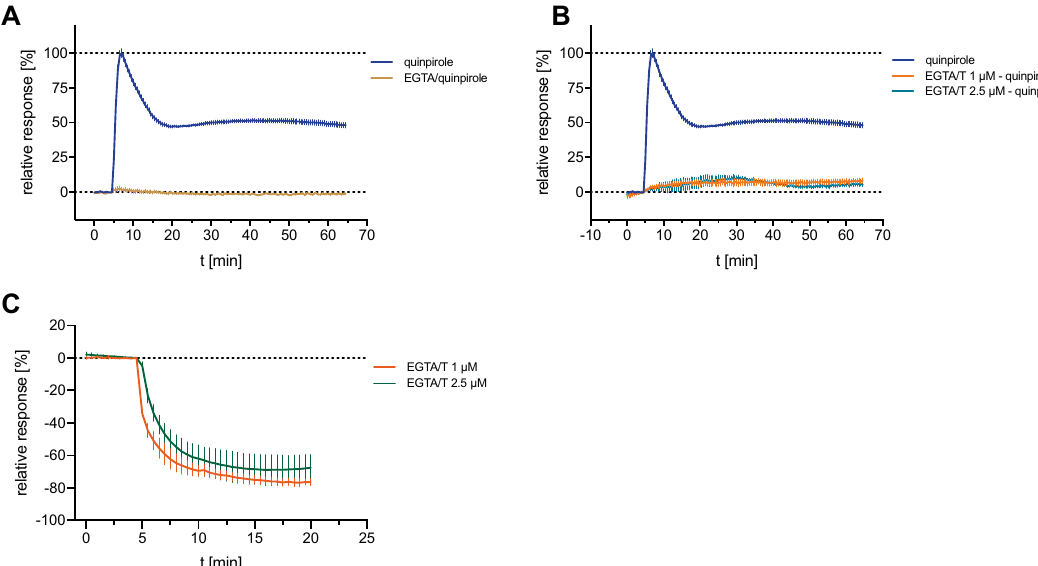
Figure 7. Effects of calcium depletion on the quinpirole-induced DMR traces of hD 2long R expressing CHO-K1 cells. ( A ) Response induced by quinpirole (1 μM) in the absence or in the presence of EGTA (2 mM) in the assay buffer. ( B ) Cells were pre-incubated with thapsigargin (1 μM or 2 μM) for 20 min before the addition of quinpirole (1 μM). EGTA (2 mM) was present in the assay buffer. ( C ) Thapsigargin-induced effect on CHO-K1 hD 2long R cells. The assay buffer was supplemented with EGTA (2 mM). In all experiments, after replacement of the medium by the EGTA-containing buffer, cells were allowed to condition in the pre-heated plate reader (28 °C) for 2 h. Data were normalised to the maximum change in wavelength shift induced by quinpirole (1 μM) observed in untreated CHO-K1 hD 2long R cells (100%) and a buffer control (0%). Data shown are means ± SEM of representative recordings performed in triplicate of three independent of [Ca 2+ ] i after stimulating the hD 2long R expressed in CHO-K1 cells with quinpirole was explored by performing a Fura-2 calcium assay. Only high concentrations of quinpirole (1 μM and 10 μM) induced a low increase in intracellular Ca 2+ concentration in CHO-K1 hD 2long R cells over the buffer control (1.7-fold, cf. Supplementary Fig. S12, SI). For comparison, activation of the muscarinic M 3 receptor, a G q/11 -coupled receptor, results in an about tenfold increase in intracellular Ca 2+ -concentration in a Fura-2 assay using CHO-hM 3 R cells 67 . Conse- quently, the abrogation of the DMR response by treatment with EGTA and/or thapsigargin must have different underlying mechanisms. A potential effect of Ca 2+ depletion on the binding of quinpirole to the receptor was considered a possible reason. Therefore, radioligand competition binding experiments were performed in the presence of EGTA (2 mM). However, the results showed that chelation of Ca 2+ ions by EGTA had no marked effect on the binding of quinpirole to the hD 2long R. (cf. Supplementary Fig. S13, SI). In conclusion, extracellular or extra- and intracellular depletion of calcium resulted in conditions under which either the hD 2long R cannot be activated or the hD 2long R-mediated signalling cannot be detected by DMR measurements. Calcium is a ubiquitous intracellular second messenger 68 which is involved in numerous cellular